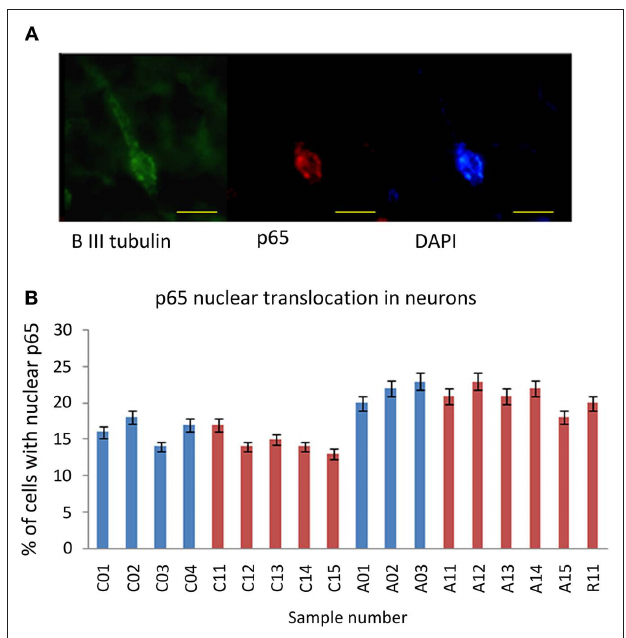
FIgURe 2 | NF- κ B p65 expression in neurons. (A) A representative image of a neuron stained with anti- β -III Tubulin (green), anti-p65 (red), and DAPI (blue). Scale bar = 10 μm. (B) Percentage of neurons with anti-p65 nuclear staining for each sample. Sample IDs prefixed “A” are from ASC donors, prefixed “C” from control